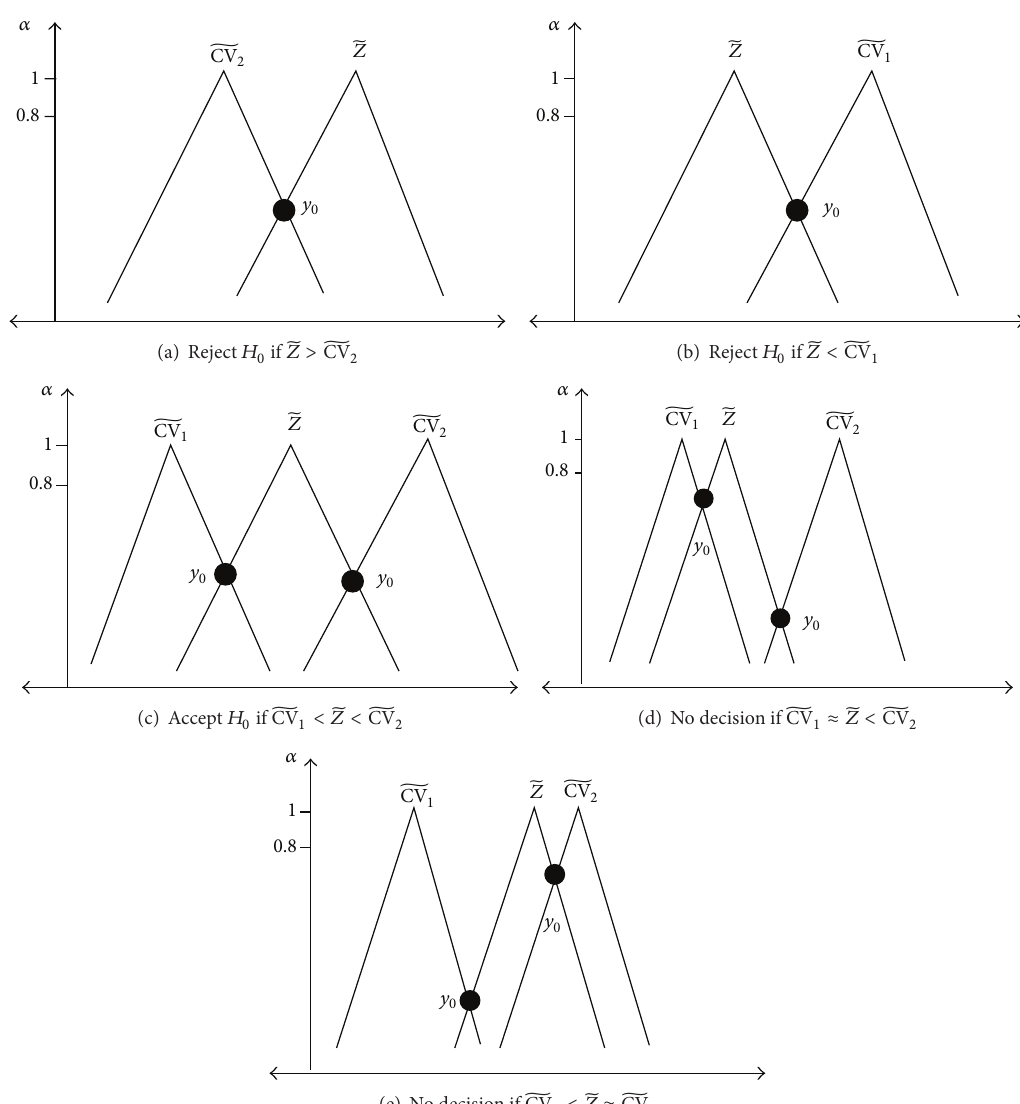
Figure 2: Decision criteria for testing 𝐻 0 : 𝜇 = 𝜇 0 versus 𝐻 1 : 𝜇 ̸=𝜇 0 using 𝛼 -cuts.